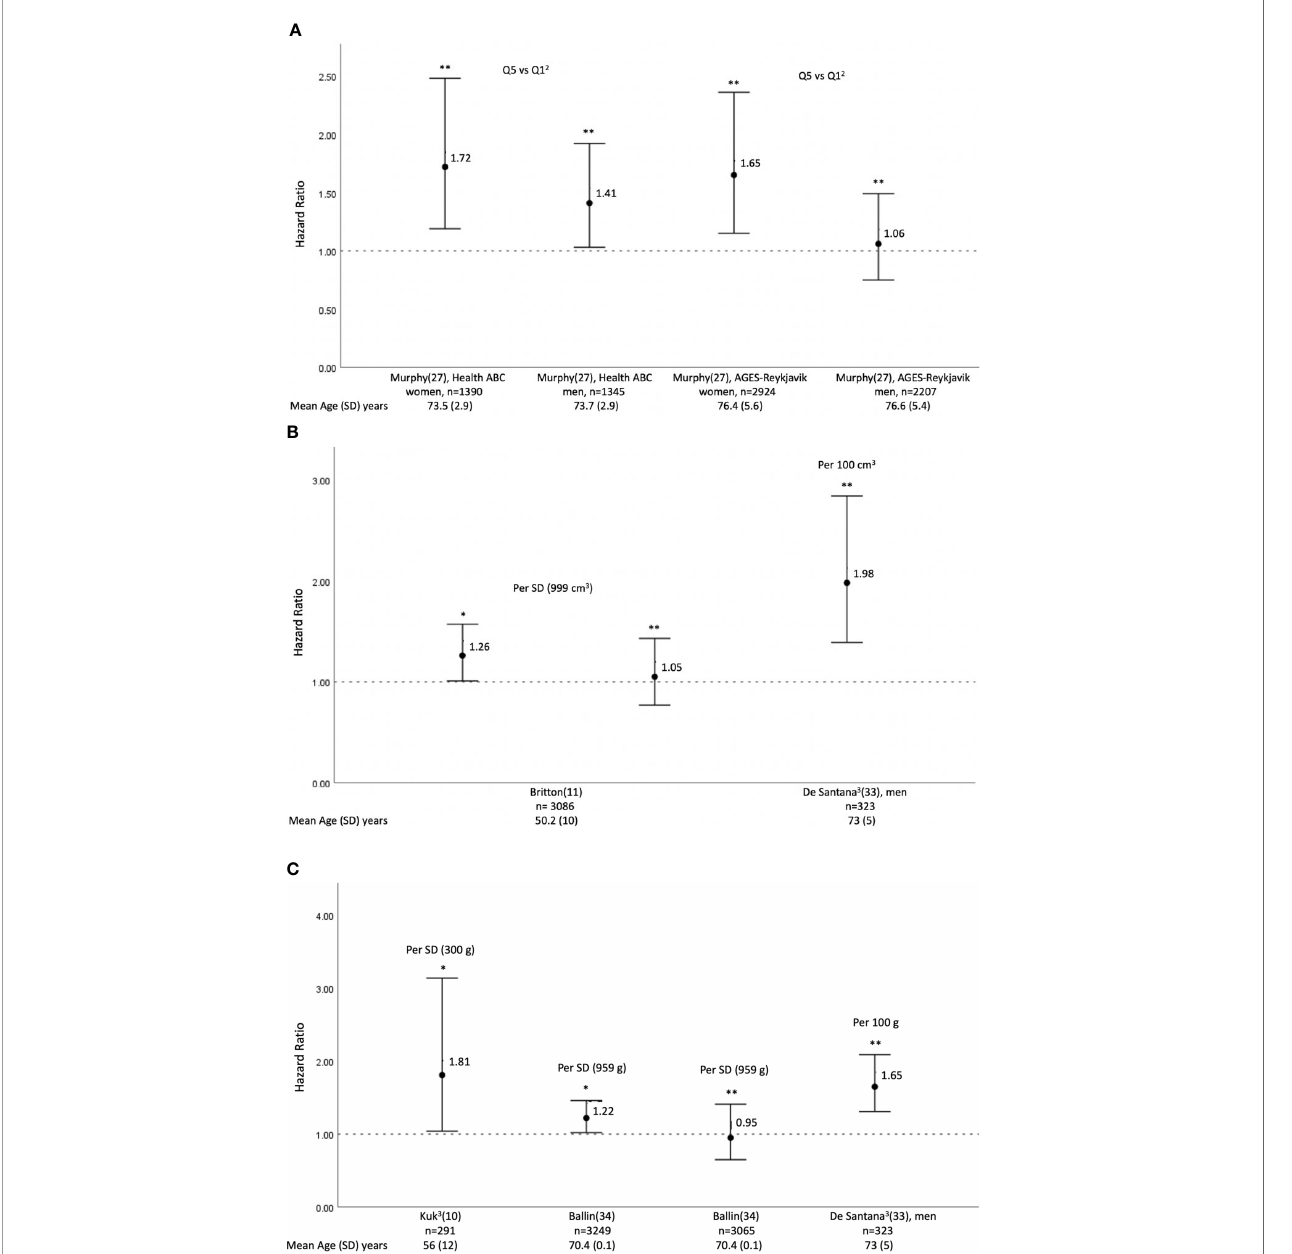
FIGURE 3 | HazardRatios 1 (HRs)an95%con fi denceintervalofall-causemortalityperincreaseinabdominalvisceraladipose (A) density 2 (g/cm 2 ), (B) volume(cm 3 ), (C) mass (g).Theincreaseineachparameterbeingde fi nedinindividualstudiesasthestandarddeviationoftheparameterconsideredorasa fi xednumber. 1 Resultreportedashazardratio (HR),unlessindicatedotherwise. 2 ResultreportedasthemostdenseabdominalvisceraladiposetissuequintileQ5,comparedtotheleastdensevisceraladiposetissuequintile Q1.3Oddsratio(OR).*UnadjustedoradjustmentdoesnotincludeBMIandglycemicparameters;Brittonetal.(11)HRadjustedforageandsex.Kuketal.(10)ORadjustedfor age,follow-uptime,abdominalsubcutaneousfat,andliverfat.Ballinetal.(34)unadjustedHR.**AdjustmentincludesBMIand/orglycemicparameters;Murphyetal.(27),AGES- Reykjavik:HRadjustedforage,education,bodymassindex,areaofrespectivefatdepot,sagittaldiameter,smokingstatus,drinkingstatus,physicalactivity,comorbidconditions, timeofcomputedtomographyscan,weighthistory(%changefrommidlife)andpriorhospitalization.Murphyetal.(27),HealthABC:HRadjustedforage,race,studysite, education.bodymassindex,fatareaofrespectivefatdepot,sagittaldiameter,smokingstatus,drinkingstatus,physicalactivity,comorbidconditions.weighthistory(%change frommidlife)andpriorhospitalization.Brittonetal.(11)HRadjustedforage,sex,systolicbloodpressure,diabetes,totalcholesterol,high-densitylipoproteincholesterol,current smoking,hypertensiontreatment,andbodymassindex.DeSantanaetal.(33)ORadjustedforage,lowlevelofphysicalactivity,recurrentfalls,highalcoholintake,diabetes mellitus,previouscardiovascularevent,serumphosphorus,calcium,albumin,25 ‐ OHVitaminDandtotalhipBMDT ‐